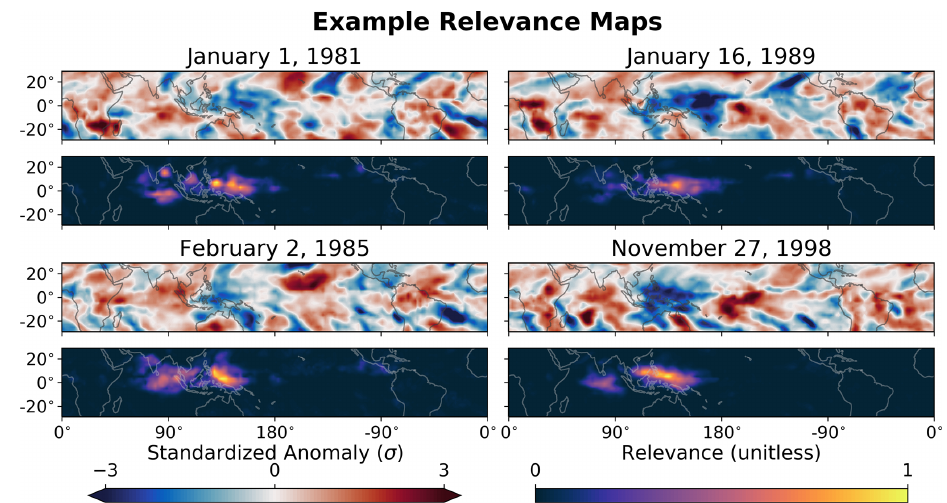
Figure 6. Example relevance heatmaps from the layerwise relevance propagation interpretation technique. The outgoing longwave radiation fields from four example inputs into the neural network are shown, each corresponding to a separate phase-7 MJO day. The corresponding relevance heatmaps are shown below each example outgoing longwave radiation field and show where the neural network focuses its attention to determine that the examples are associated with a phase-7 MJO